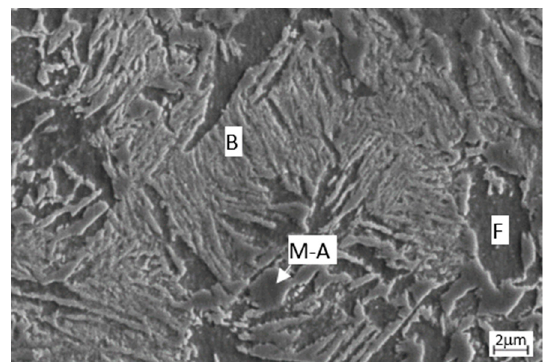
Figure 4. Heat treatment parameters: Soaking 900 °C/100 s, cooling rate 30 °C/s, bainitic hold 400 °C/600 s. Predominantly bainitic microstructure with polygonal ferrite grains and M-A constituent islands.